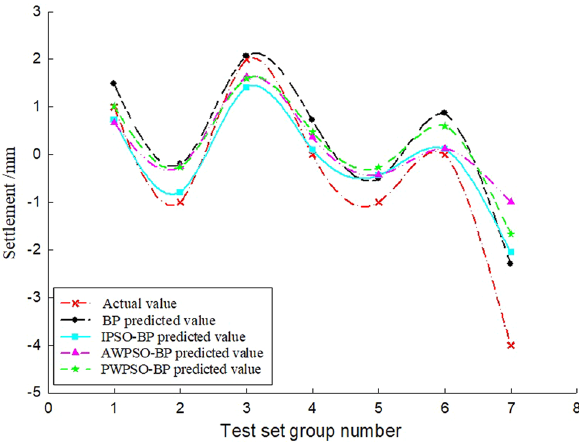
Figure 7. Right Y1 measuring